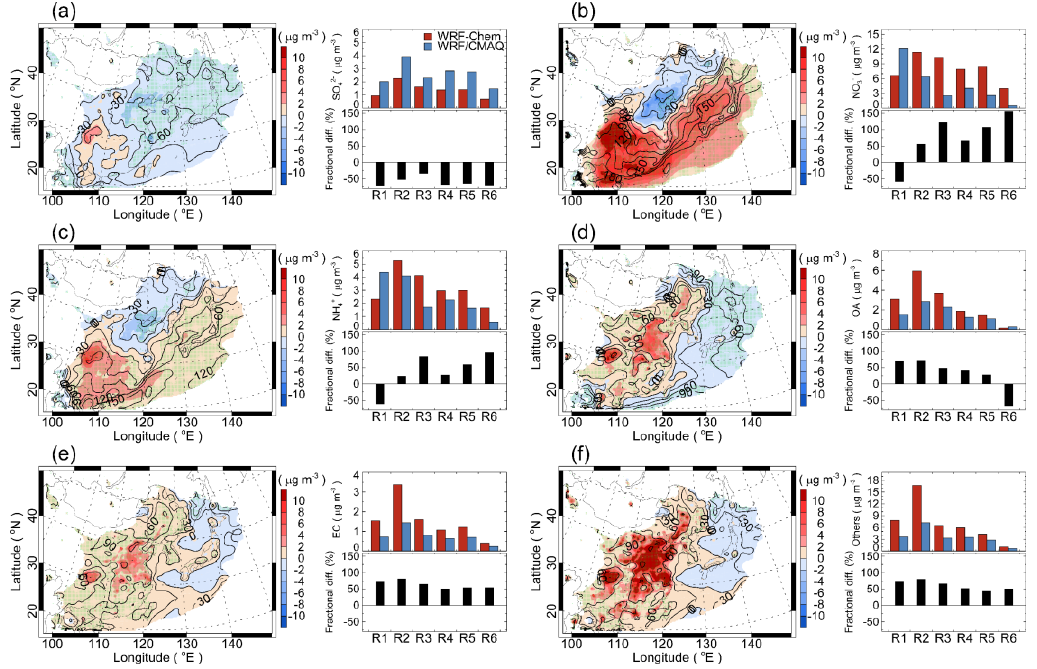
Figure 9. ( a ) Spatial distribution of the concentration difference (shaded) and the fractional difference (line contour) in the surface PM 2.5 concentrations simulated by the WRF-Chem and WRF/CMAQ models, ( b ) mean concentrations and ( c ) fractional differences at each subdivision. Green dots denote the areas where the relative difference is statistically significant within 95%.